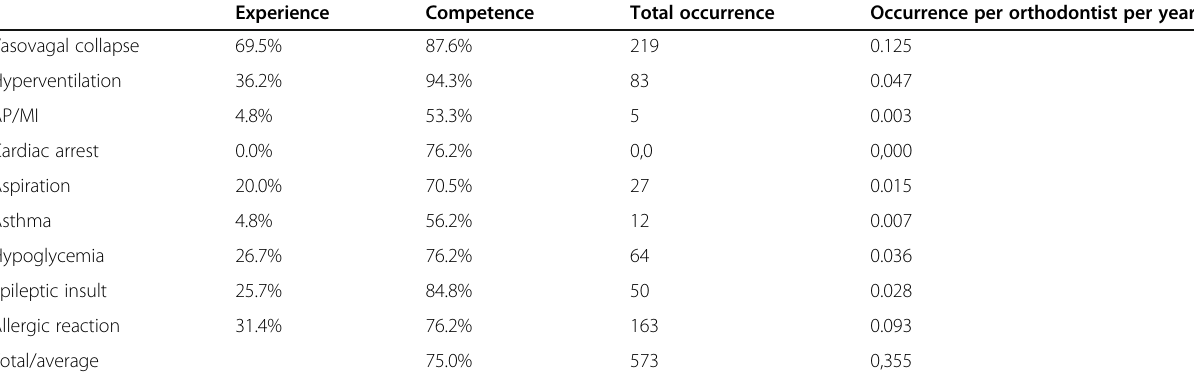
Table 2 Experience and perceived competence with common medical emergencies